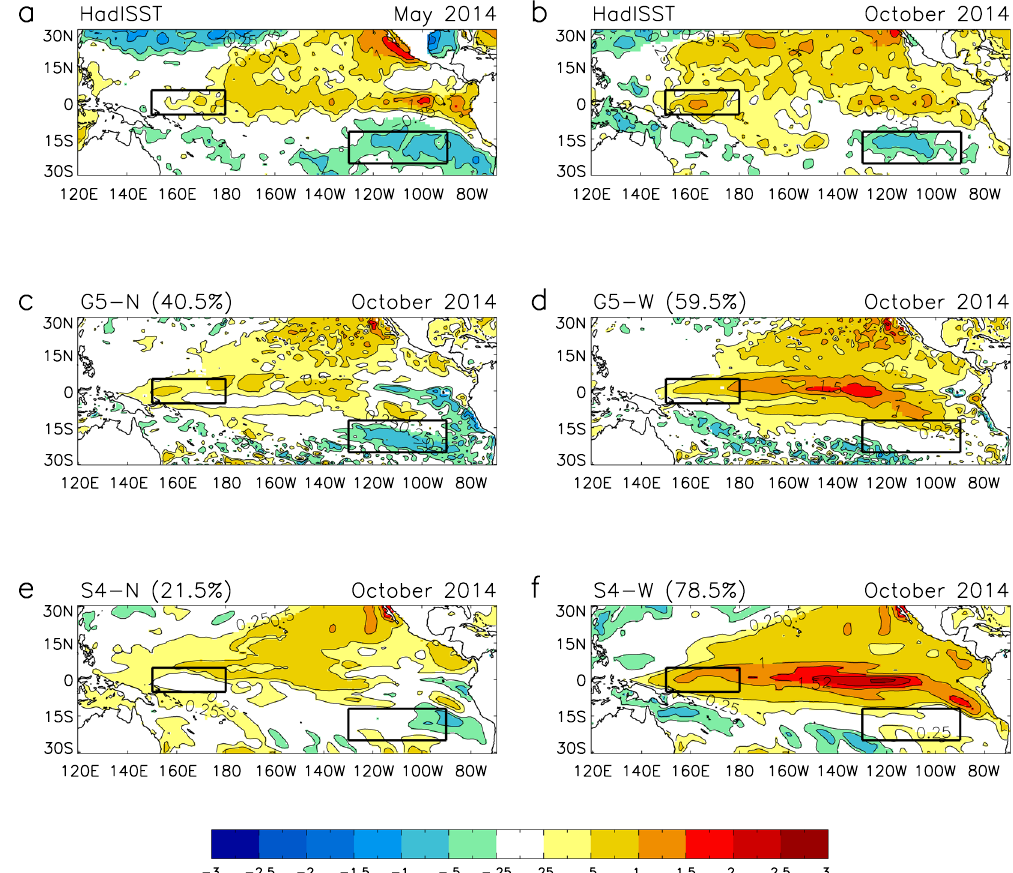
Figure 2. Categorising forecast ensemble members initialised in May 2014 as ‘neutral’ or ‘warm’ ENSO composites. Observed (HadISST1.1) tropical Pacific SST anomaly for ( a ) May 2014 and ( b ) October 2014. Composite forecast SST anomalies for October 2014 for ( c ) ‘neutral’ G5 members, ( d ) ‘warm’ G5 members, ( e ) ‘neutral’ S4 members and ( f ) ‘warm’ S4 members. Categories for composites are based on forecast October SST anomaly: − 0.8 °C < ‘neutral’ < 0.8 °C ≤ ‘warm’. Boxes show the west Pacific area (150°E-180°, 5°N-5°S) and the